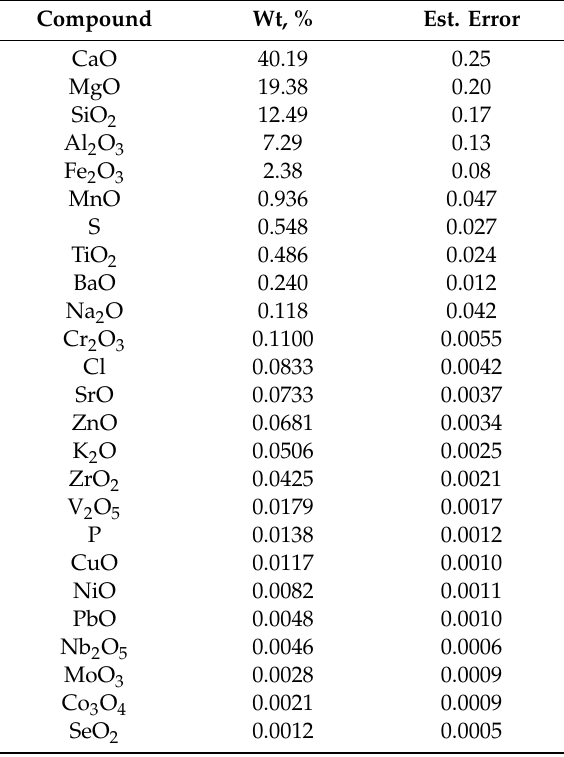
Table 5. Results of the X-ray fluorescence of ladle furnace